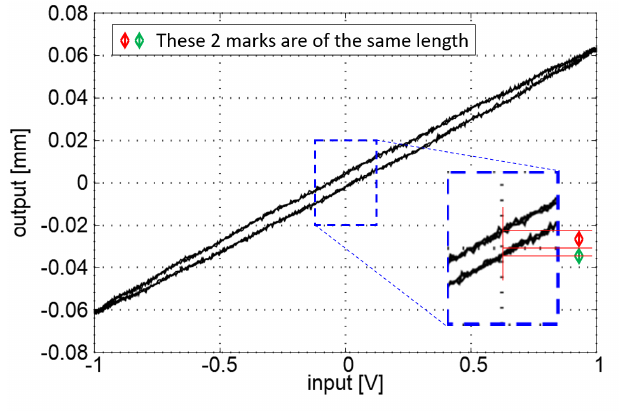
Figure 2. An example of the off-center asymmetric hysteresis loop of the piezoelectric actuator used in this